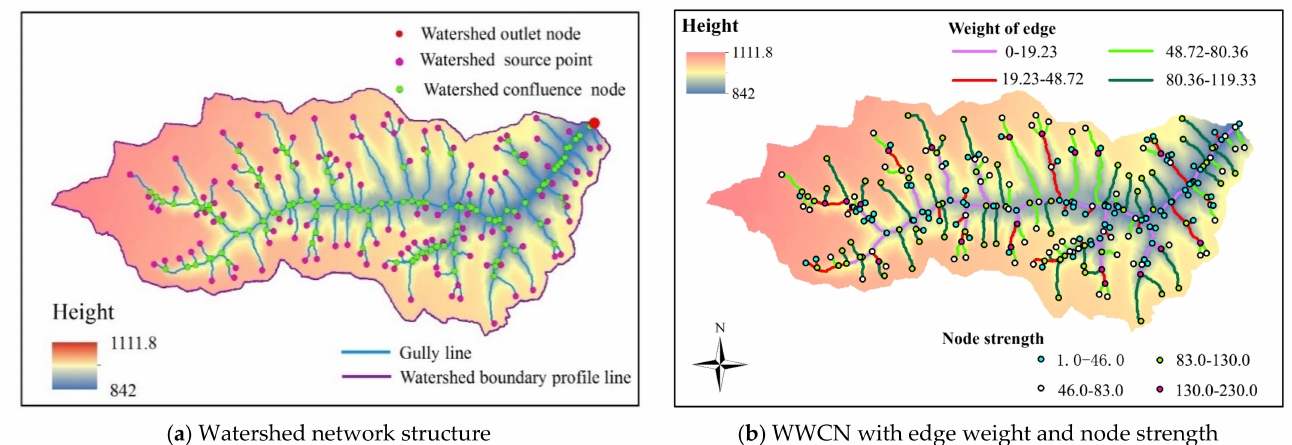
Figure 7. The form of the watershed network ( a ) and the WWCN spatial structure with the edge weight and node strength ( b ).